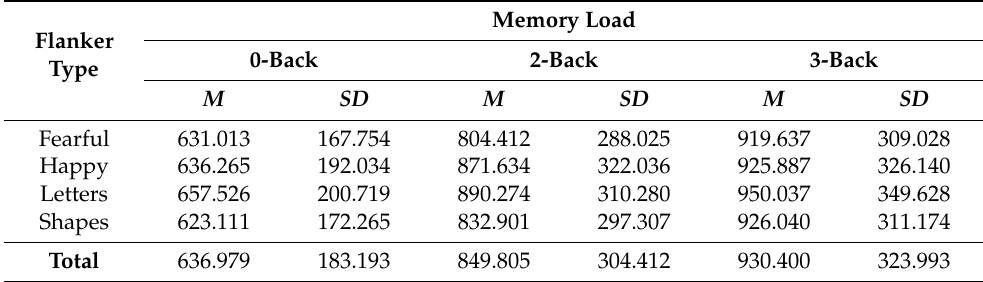
Table 4. Descriptive statistics of participants’ mean reaction times for Hits (before log-transformed).